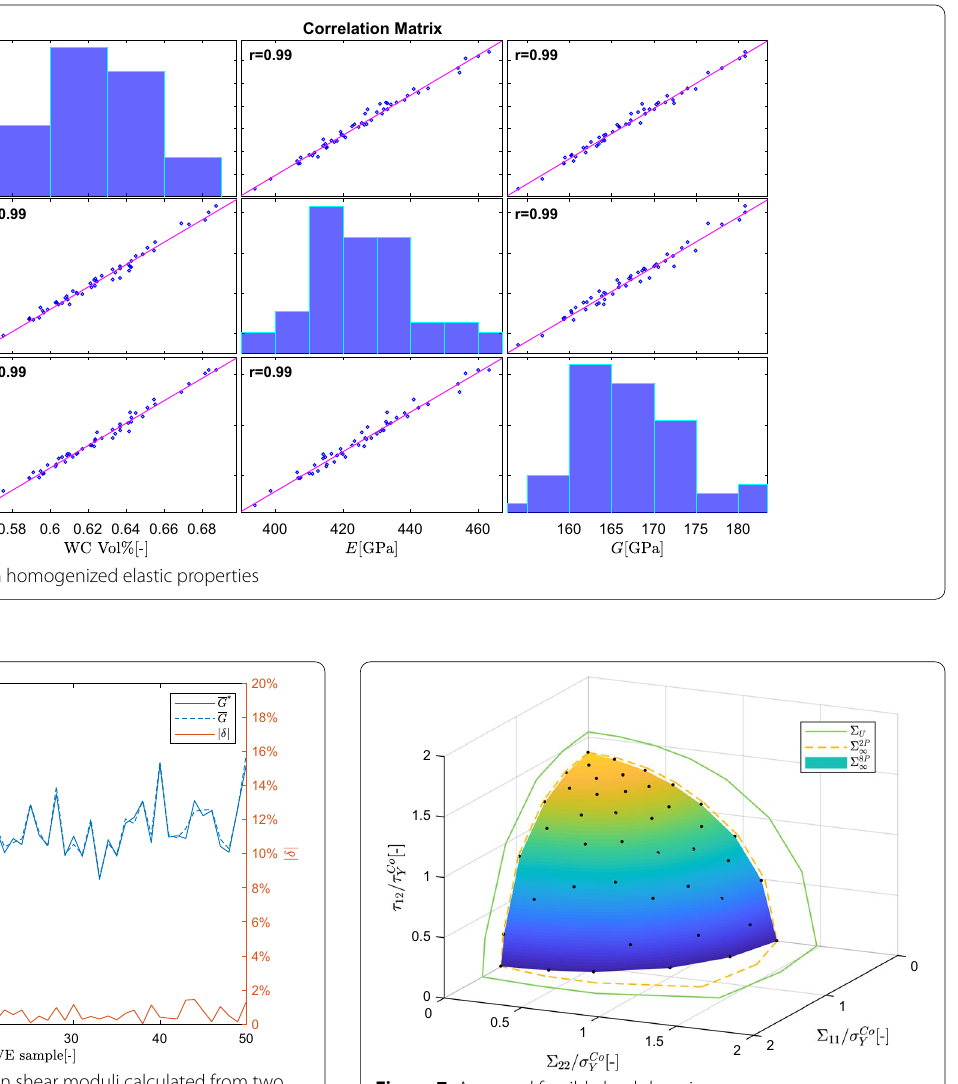
Figure 7 Averaged feasible load